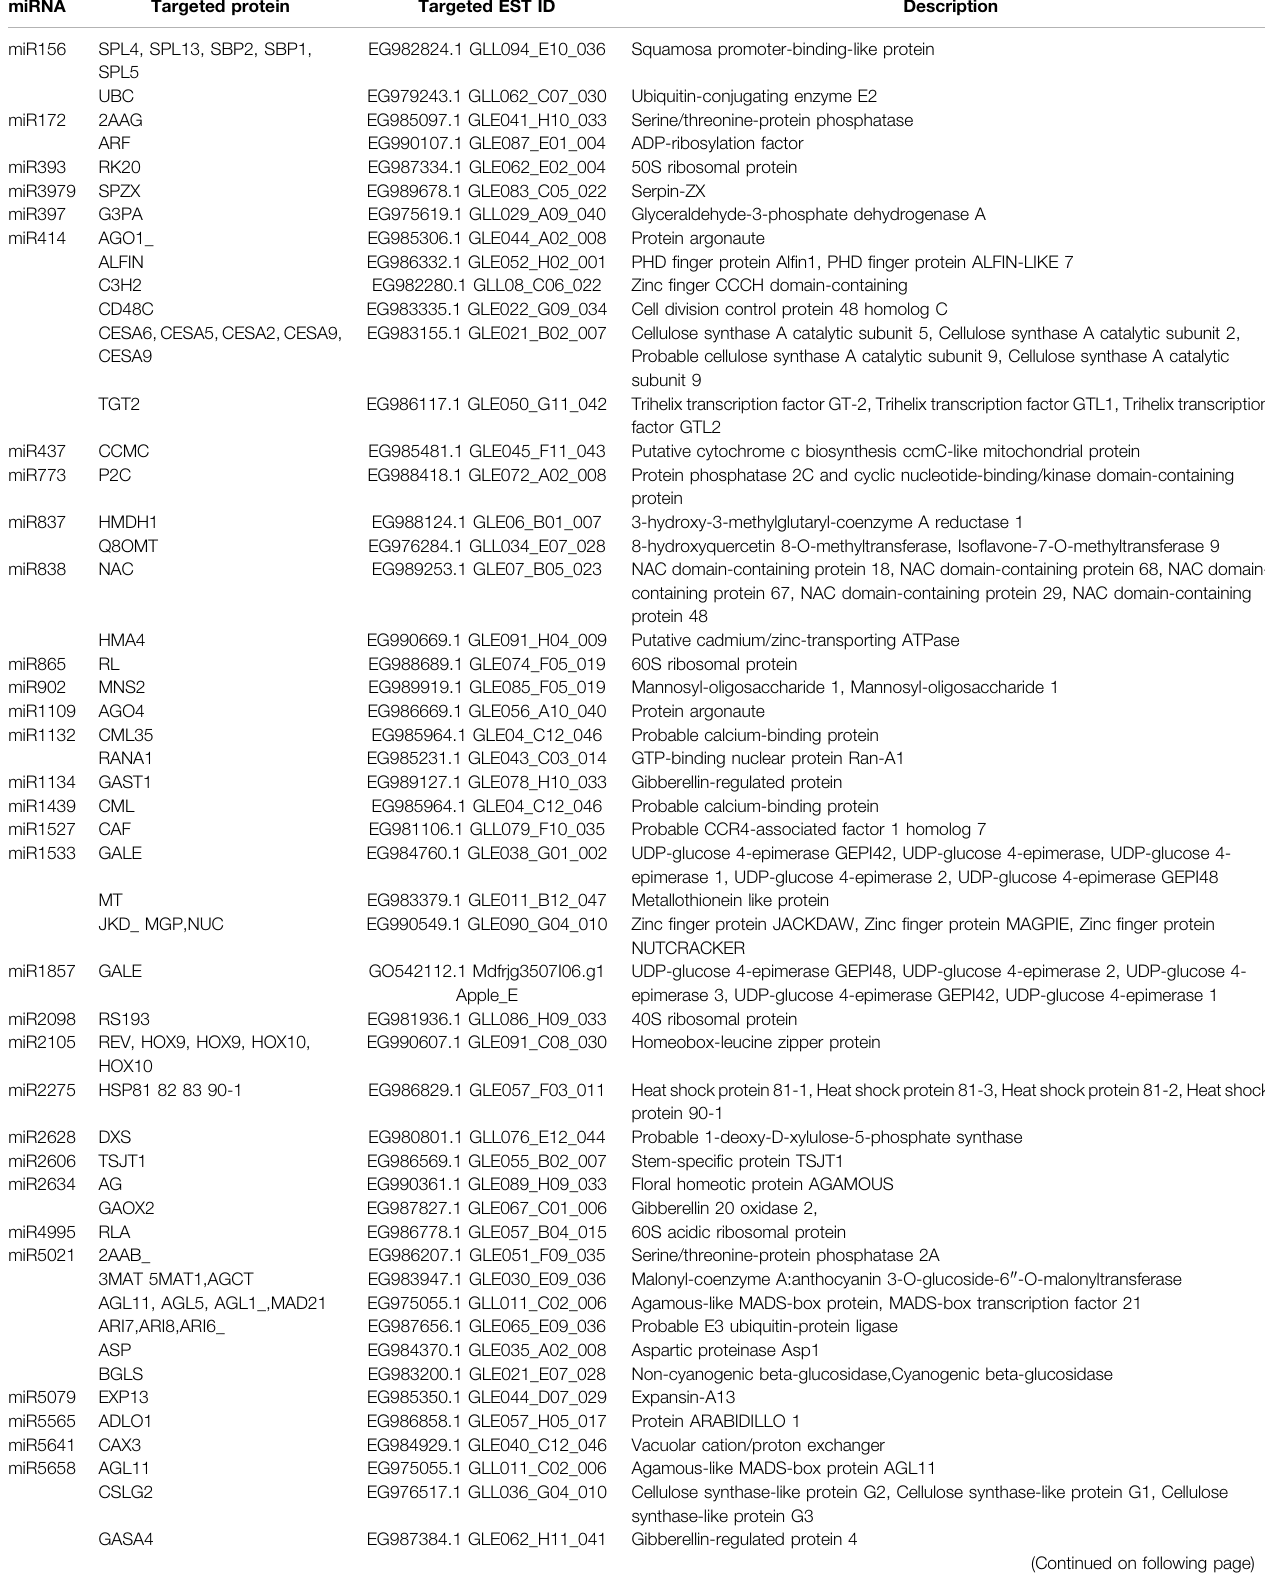
TABLE 2 | Major potential target genes for predicted miRNAs in cluster